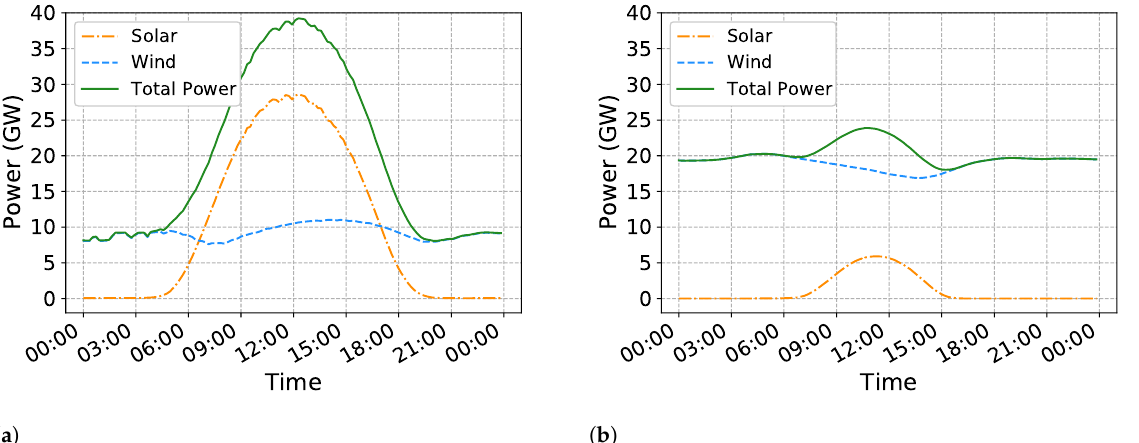
Figure 3. Average energy generation from renewables in Germany, determined from data for two weeks in summer and winter 2021 [49]. ( a ) Average summer day. ( b ) Average winter day. To compensate for fluctuations in power generation (e.g., summer day with zero hours of sunshine), the average values from two weeks are used to generate the